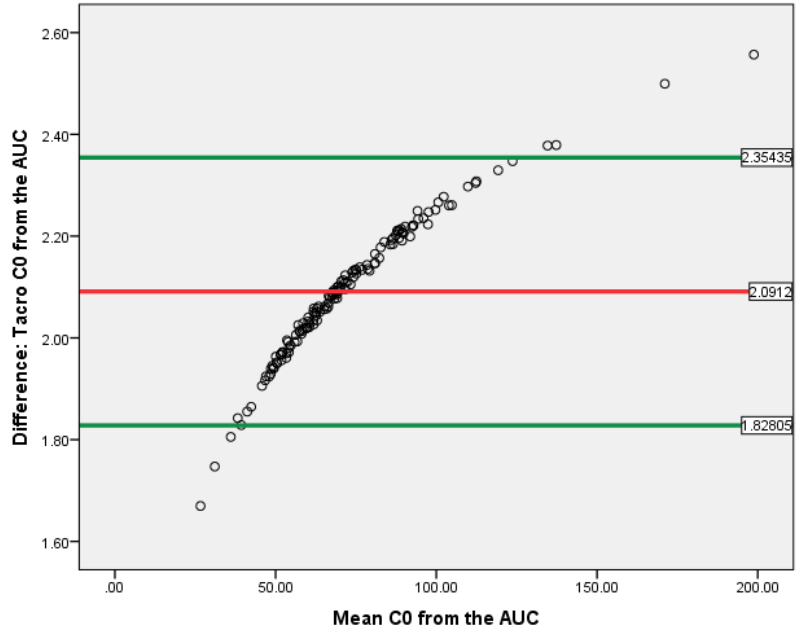
Figure 8. Bland–Altman plot for Tacro C 0 and AUC (0–12) in kidney recipients. The horizontal red line delineates the log ‐ mean difference between C 0 and AUC (0–12) , the upper and the lower horizontal green lines delineate ± 1.96 × standard deviation.